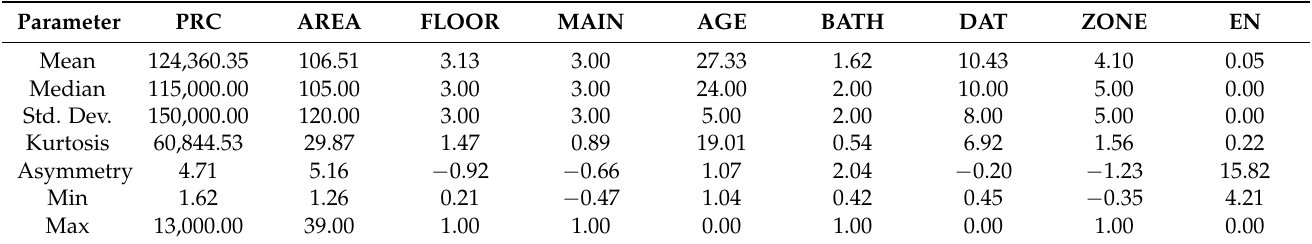
Table 2. Statistical description of variables.